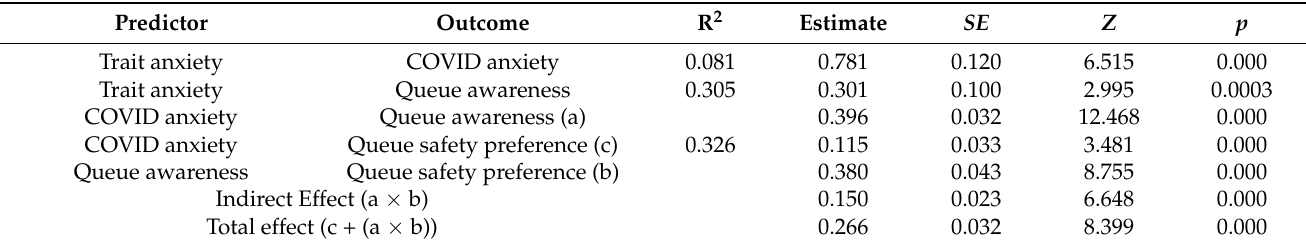
Table 4. Queue awareness path